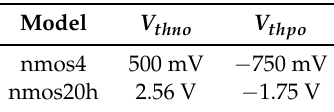
Table 1. Threshold voltages for models in